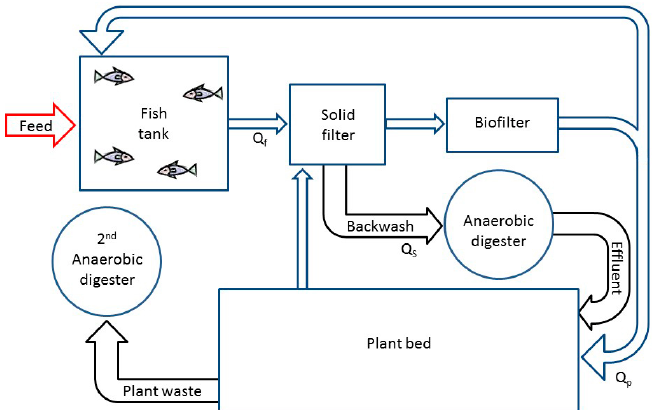
Figure 3. Scheme of the suggested three treatment loops aquaponic system model. The first loop includes a fish tank, a solid filter and an aerobic biofilter. The second loop is the plant growing unit. The third loop consists of two anaerobic digesters, one for fish sludge digestion and the second for uneaten plant biomass. Each one of the treatment loops operates under different recirculation rates and therefore different retention times. Q f is the water flux in the first loop, Q s is the sludge flux removed from the solid filter and Q p is the water flux from the biofilter into the plant bed. Nitrogen, carbon and energy mass balance equations were established [35] for the suggested system, using constants/coefficients from relevant literature (Table 1). The two main assumptions made in the model were that the system operates in a steady state (i.e., no accumulation of nutrients) and that fish feed is the only input of nutrients. Table 1. Constants and parameters used in the model.